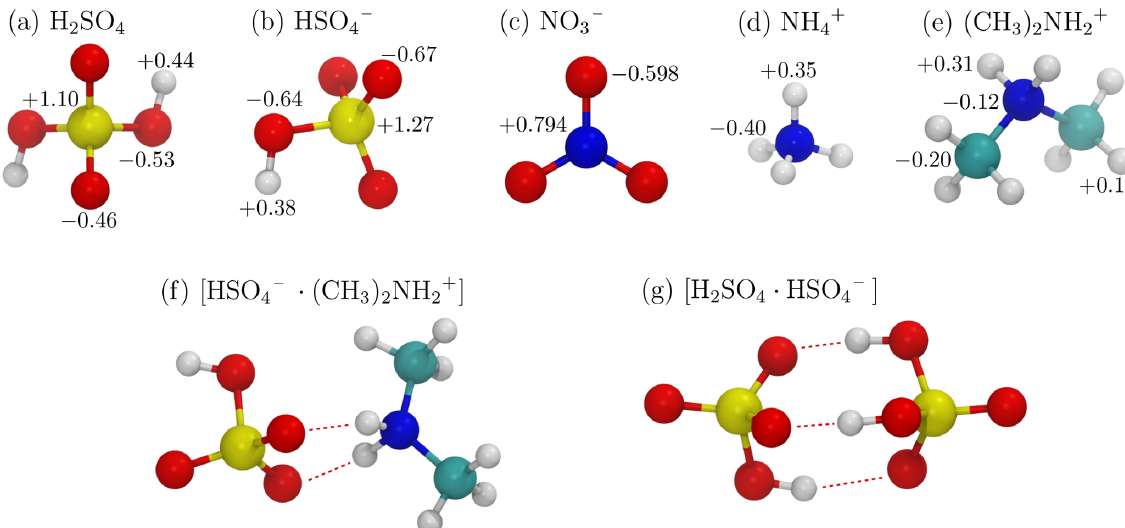
Figure 2. Stick-and-ball representations of the studied dipoles and ions, including (a) a sulfuric acid molecule, (b) bisulfate, (c) nitrate, (d) ammonium, (e) dimethylammonium ions, (f) a neutral bisulfate–dimethylammonium dimer, and (g) a charged sulfuric acid–bisulfate dimer. Atom partial charges according to the force field are indicated in panels (a) – (e) . The color codes of the atoms are as follows: sulfur – yellow, oxygen – red, nitrogen – blue, carbon – cyan, and hydrogen – white. Hydrogen bonds in the dimer structures (f, g) are indicated by dashed red